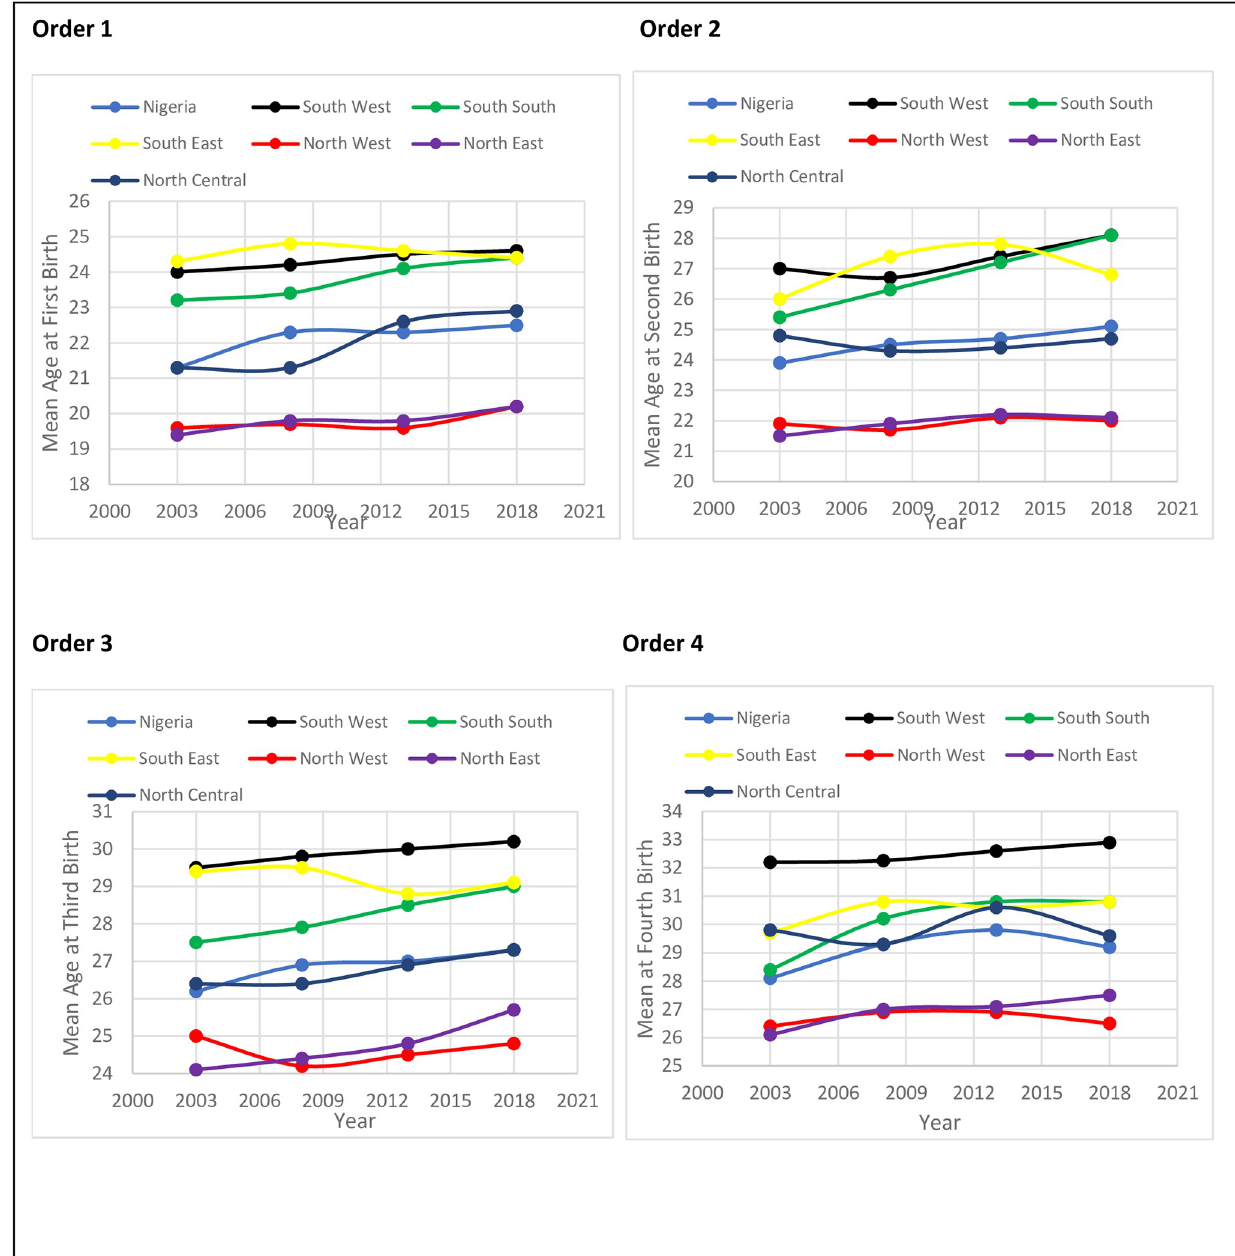
Fig 1. The mean age at childbearing